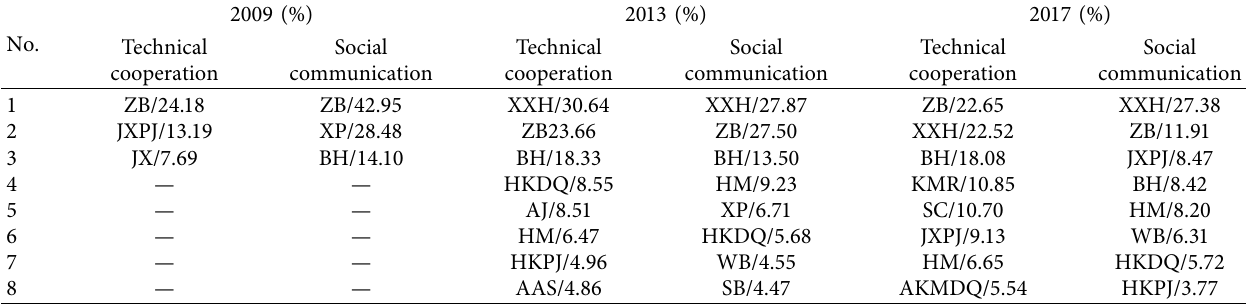
Table 4: Intermediary node and its betweenness centrality of refrigeration firms network in Minquan County. No.